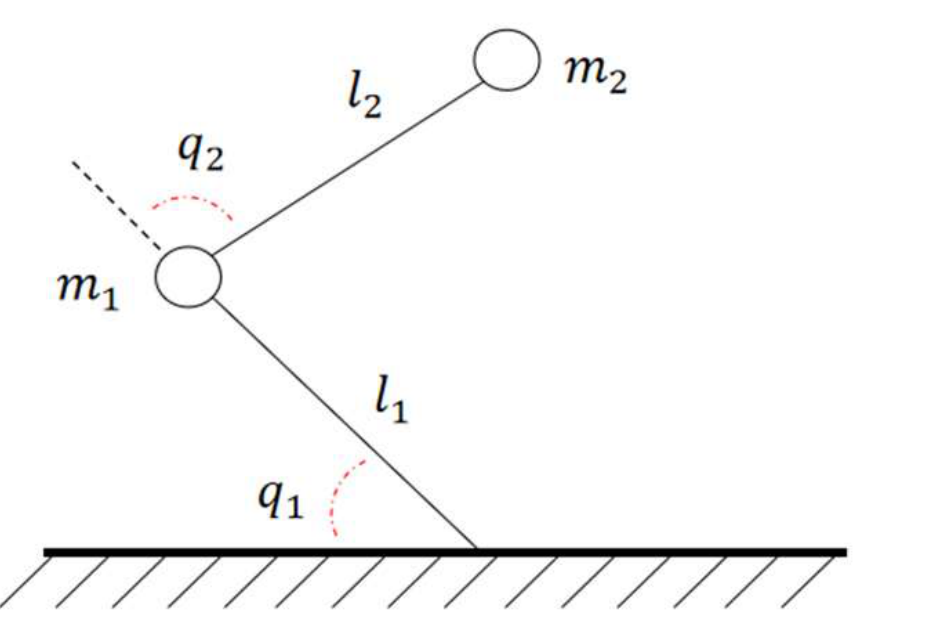
Figure 5. 2-rigid-link robotic manipulator. The system parameters are given in Table 1, which are the same as [26]. Table 1. Parameters of robotic manipulator. Parameter